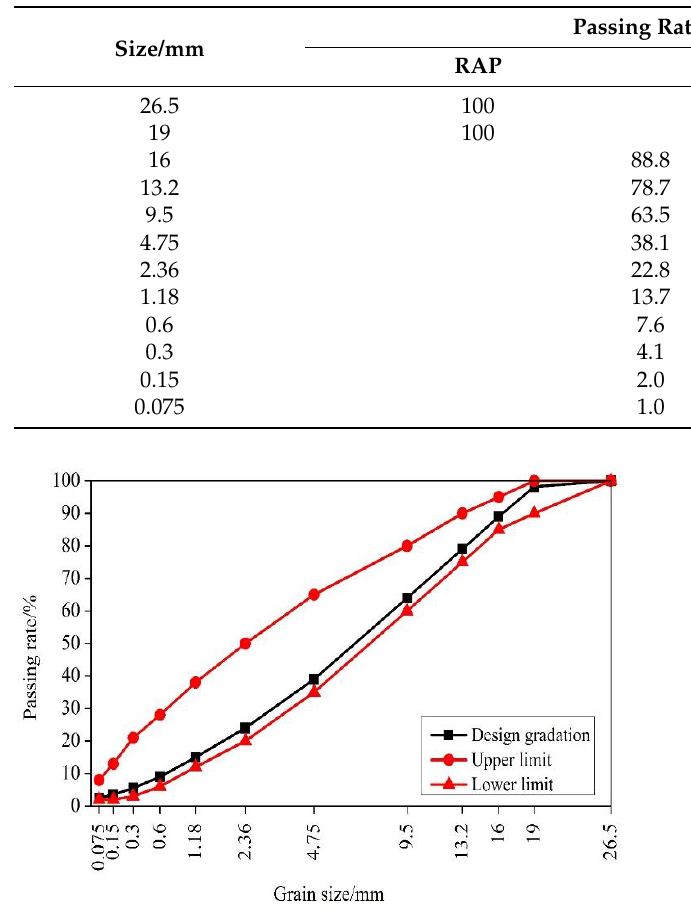
Figure 1. Grading curve of